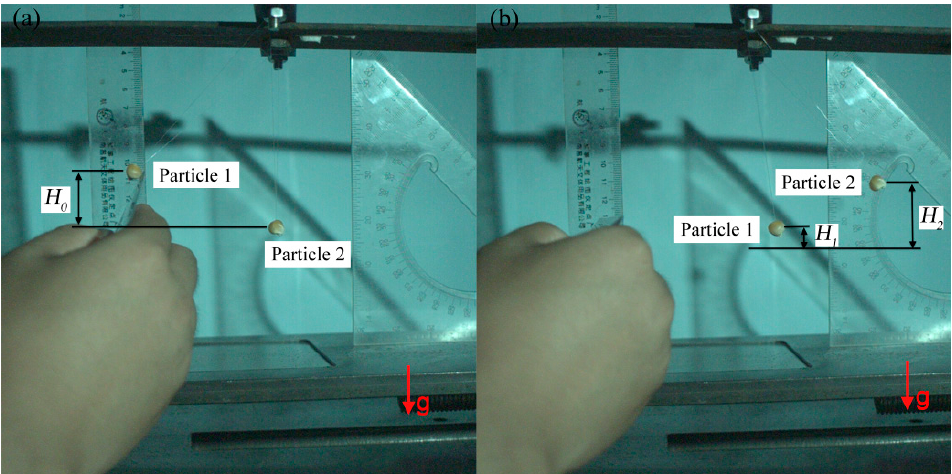
Figure 2. Platform to test the coefficient of restitution between seed particles: ( a ) initial position and ( b ) the position of the highest point after a collision.